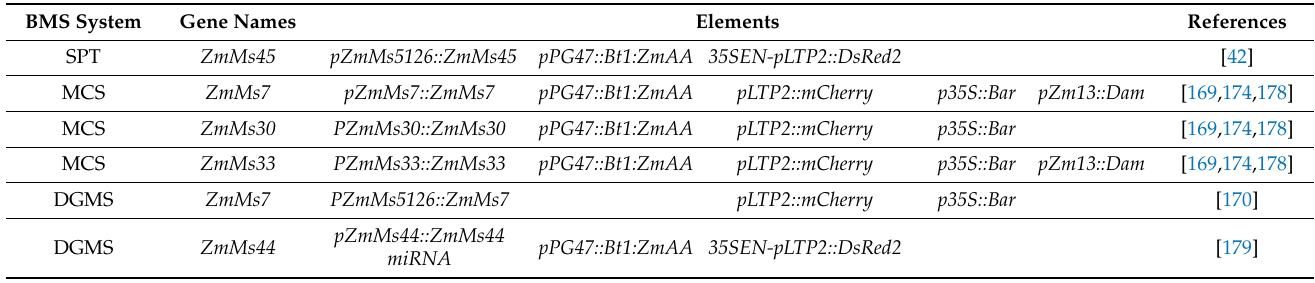
Table 3. Breeding application of GMS genes in